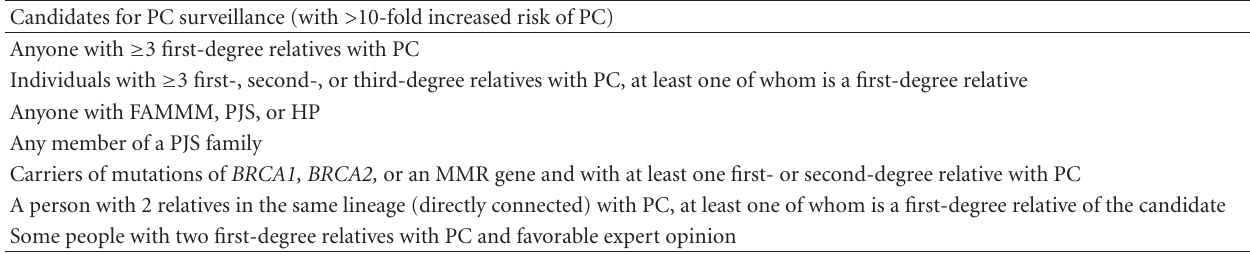
Table 4: Candidates for pancreatic cancer surveillance.